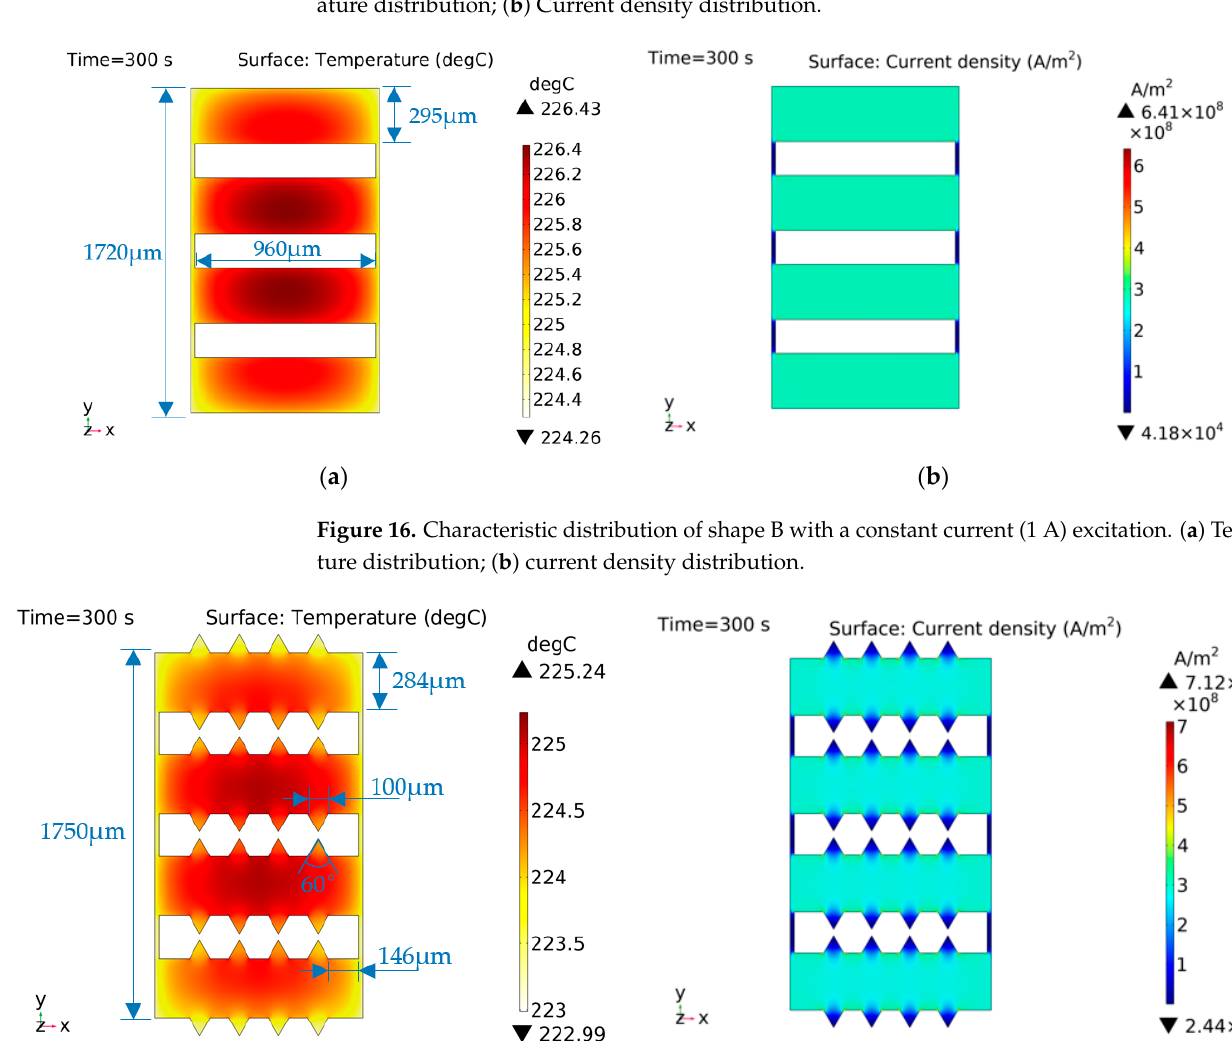
Figure 15. Characteristic distribution of shape A with a constant current (1 A) excitation. ( a ) Temperature distribution; ( b ) Current density distribution.